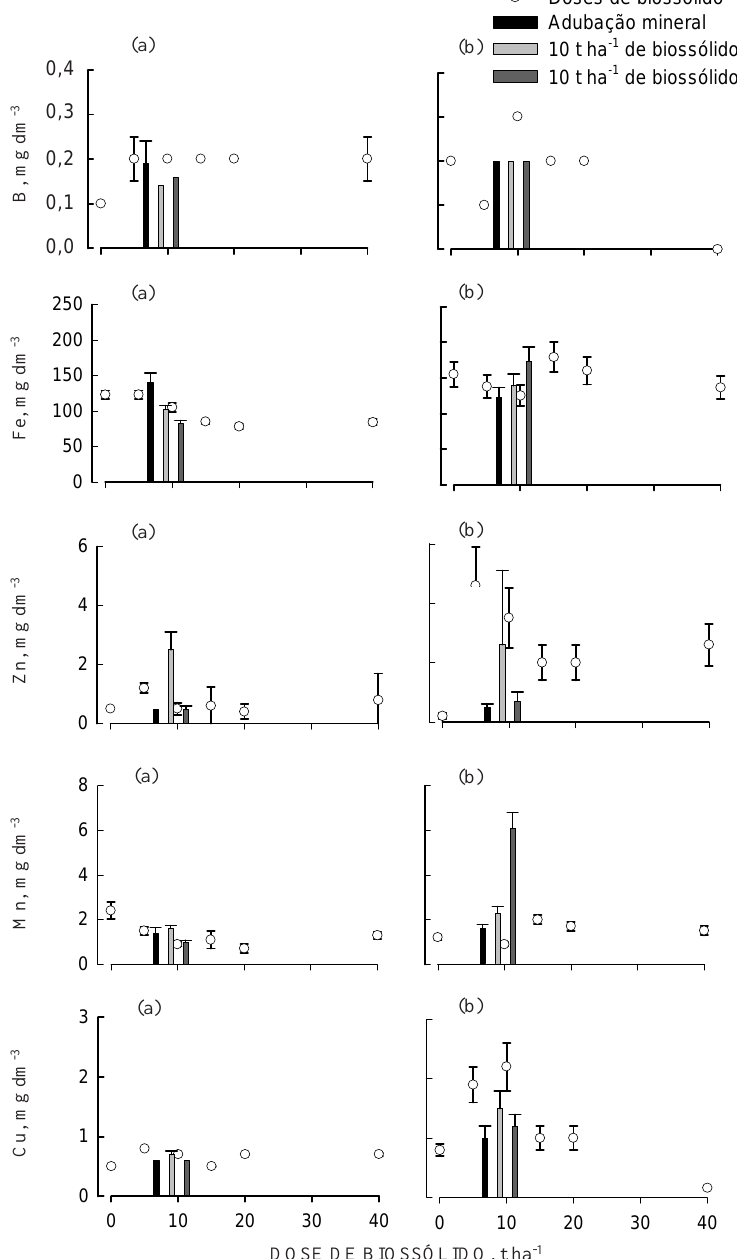
Figura 3. Teores de micronutrientes no solo (média ± erro-padrão), camada de 0-5 cm, nas entrelinhas do povoamento de Eucalyptus grandis em resposta às doses crescentes de biossólido, com suplementação de K (biossólido + KCl = 165 kg ha -1 de K), às aplicações de 10 t ha -1 de biossólido, sem suplementação de K e com suplementação de K e P, e à adubação mineral sem biossólido aos (a) 6 meses e (b) 13 meses da aplicação do